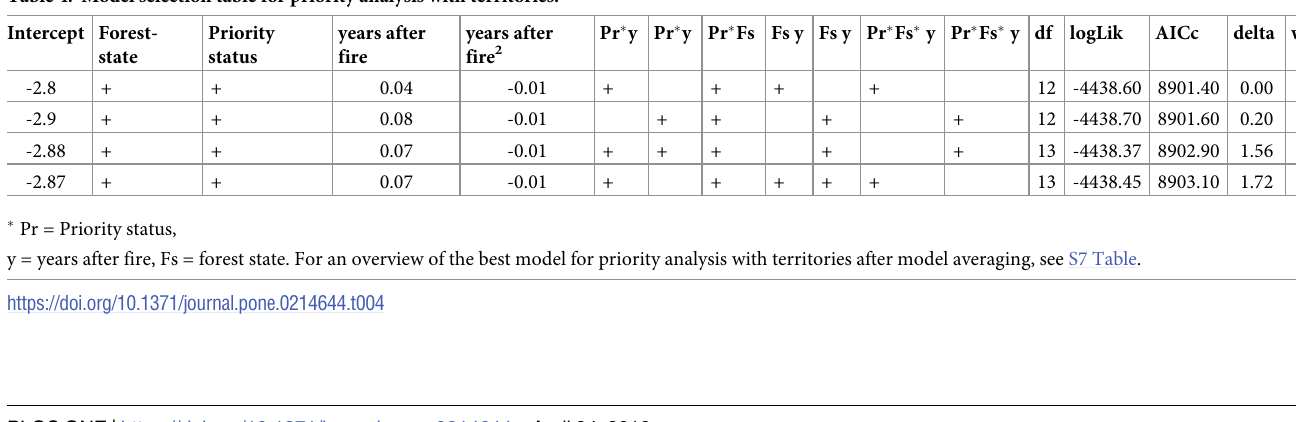
Table 4. Model selection table for priority analysis with territories.